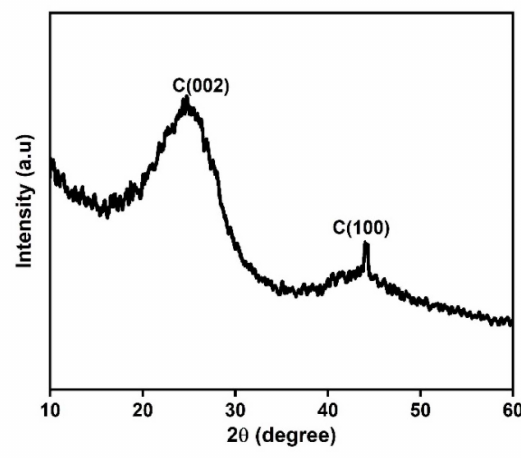
Figure 2. XRD di ff ractogram for the optimized mesoporous sulfonated carbon (OMSC)